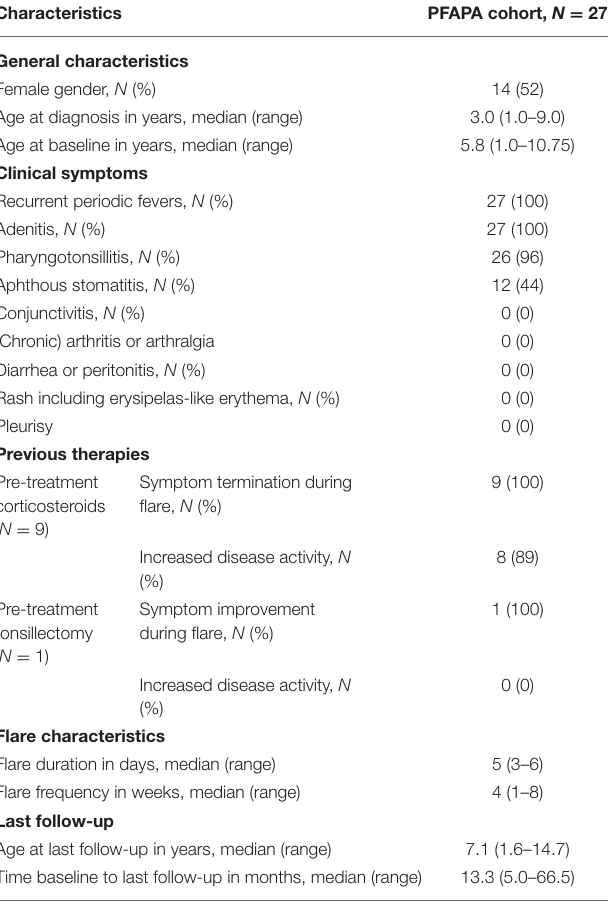
TABLE 1 | Baseline characteristics of PFAPA patients treated with colchicine.